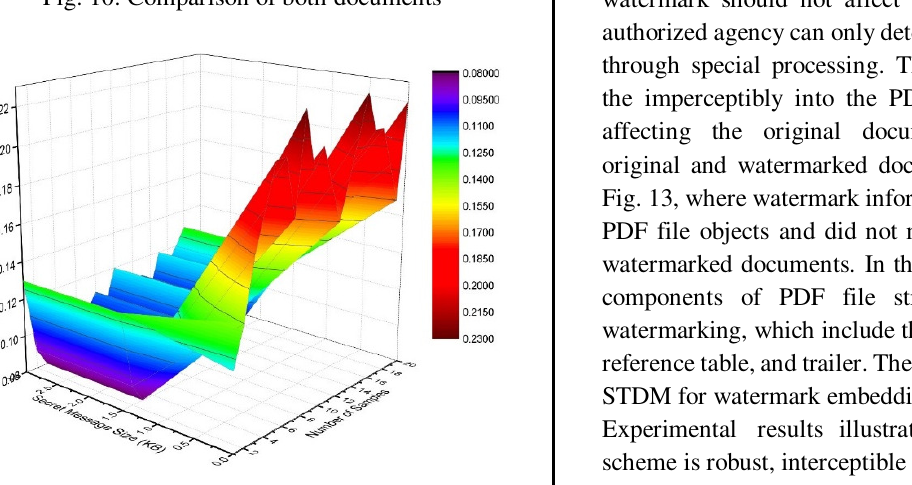
Fig. 11: 3D representation of capacity analysis